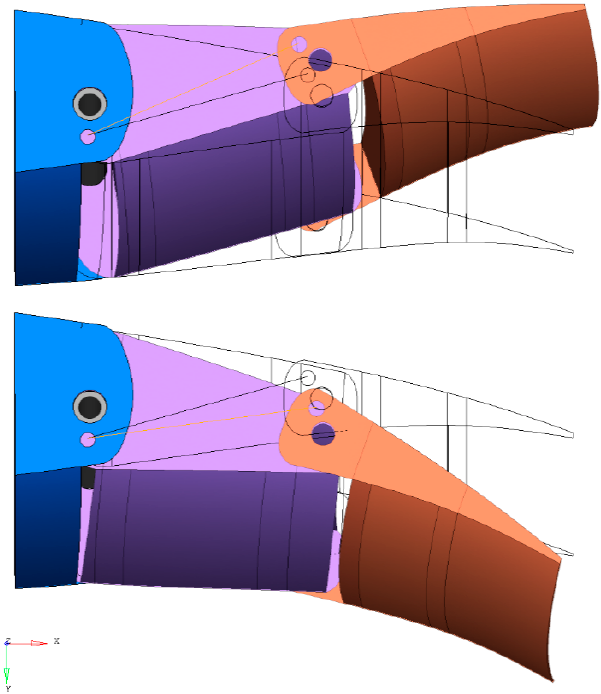
Figure 3. Morphing blocks of the finger-like architecture, [20].